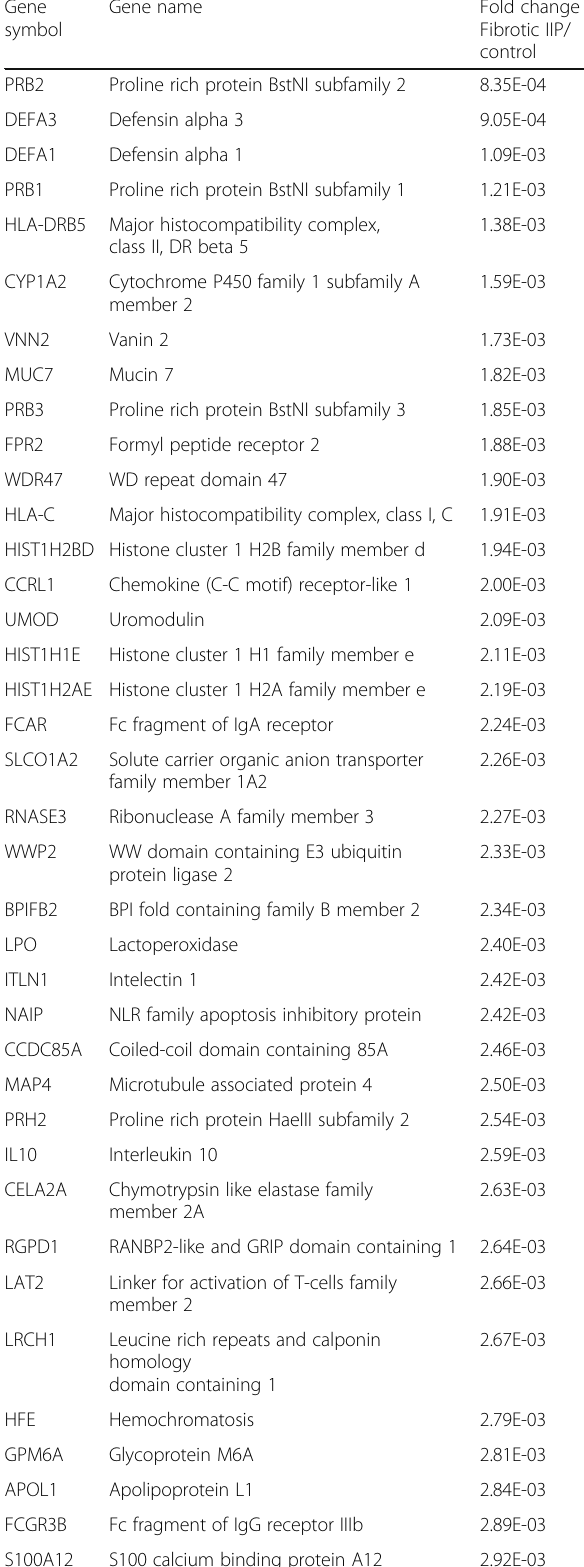
Table 3 Top 50 known genes downregulated in IIP patients